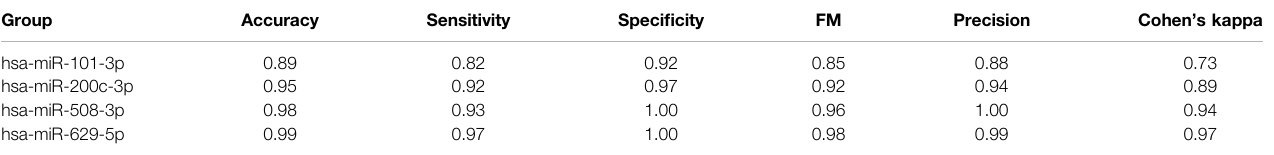
Each miRNA ID represents a group, which is generated by the Grouping Component G. Groups are sorted according to the accuracy metric.